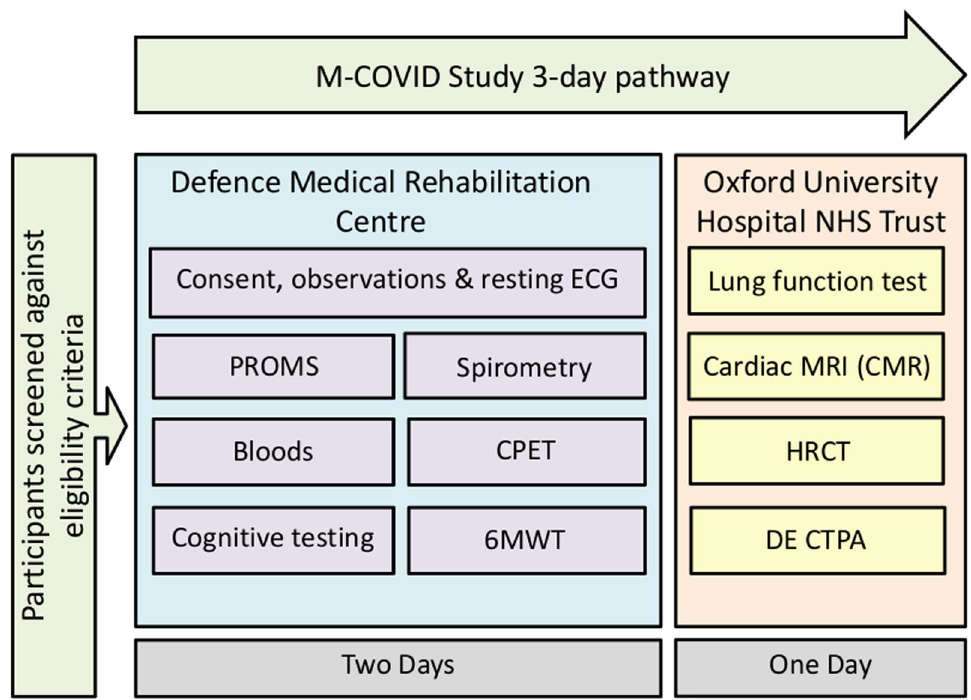
Fig. 1 Diagrammatic description of study design. Abbreviations: ECG, electrocardiogram; PROMS, patient‑reported outcome measure; CPET, cardiopulmonary exercise test; 6MWT, six‑minute walk test; MRI, magnetic resonance imaging; CMR, cardiac magnetic resonance imaging; HRCT, high‑resolution computed tomography; DE CTPA, dual‑energy computed tomography pulmonary